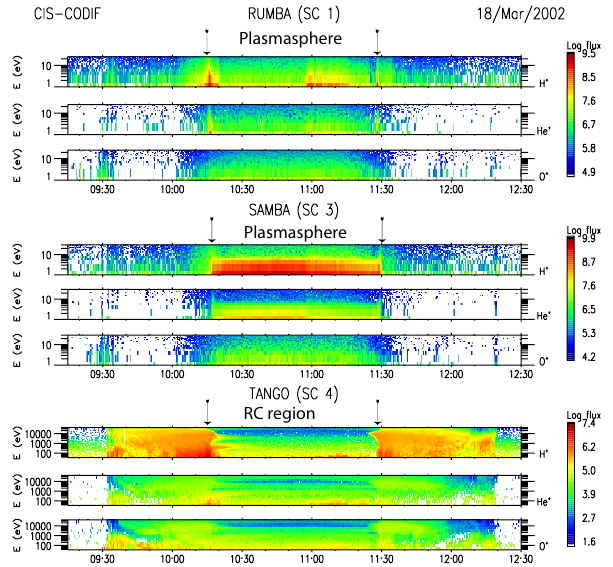
CIS-CODIF data for the 18 March 2002 event: H + , He + , O + energy-time spectrograms in particle flux units (ions/cm 2 sr skeV) from SC1, SC3 and SC4. CODIF on SC1 and SC3 were using the RPA mode, allowing measurements of plasma particles from ∼ 1eV to ∼ 25eV, characteristic of the plasmasphere. CODIF on SC4 was operating in a normal magnetospheric mode (25eV–40keV) which allows the detection of the ring current par- ticles. We thus are using the SC1 and 3 to monitor the position of the plasmasphere/plasmapause, and SC4 to monitor the ring cur- rent. As it appears on these 3 spectrograms, and taking into account Fig. 9. Cluster data for the 18 March 2002 event: H + energy-time that the spacecraft separation was only a few hundred kilometers, spectrogram for SC4 in particle flux units (ions/cm 2 srskeV), cur- the plasmasphere and the ring current boundaries were almost col- rent density components in the SM coordinate system and in nA/m 2 located for this event, at the MLT sector of the Cluster trajectory (second panel), and in the local cylindrical coordinate system (bot- (see text for details). tom panel). Black dashed lines demarcate the ring current region. L-shell, invariant latitudes, magnetic latitudes and geocentric dis- tances are indicated